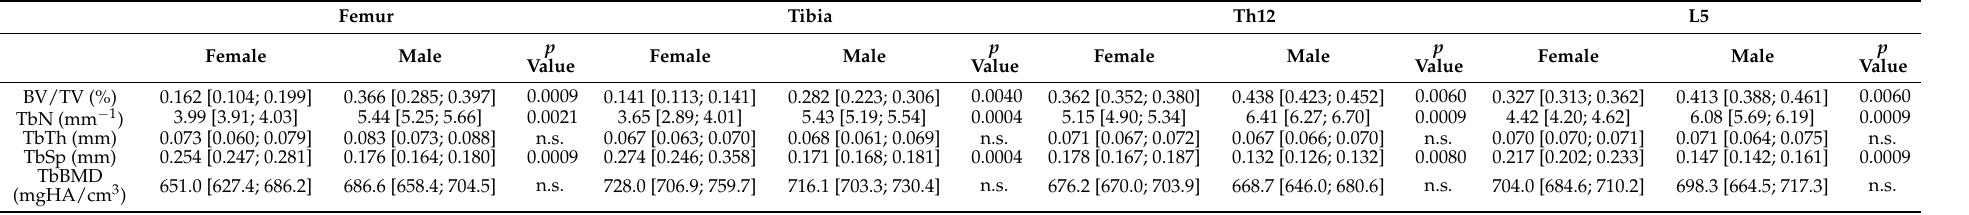
Table 1. Trabecular bone mineral density and microarchitecture at four different skeletal sites in female (n = 10) and male (n = 10) C57BL/6J mice at 6-month of